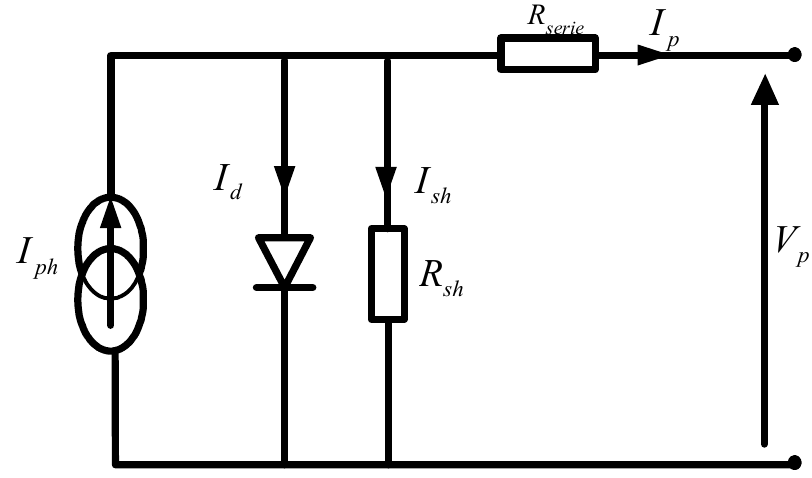
Figure 2. Photovoltaic cell equivalent circuit.